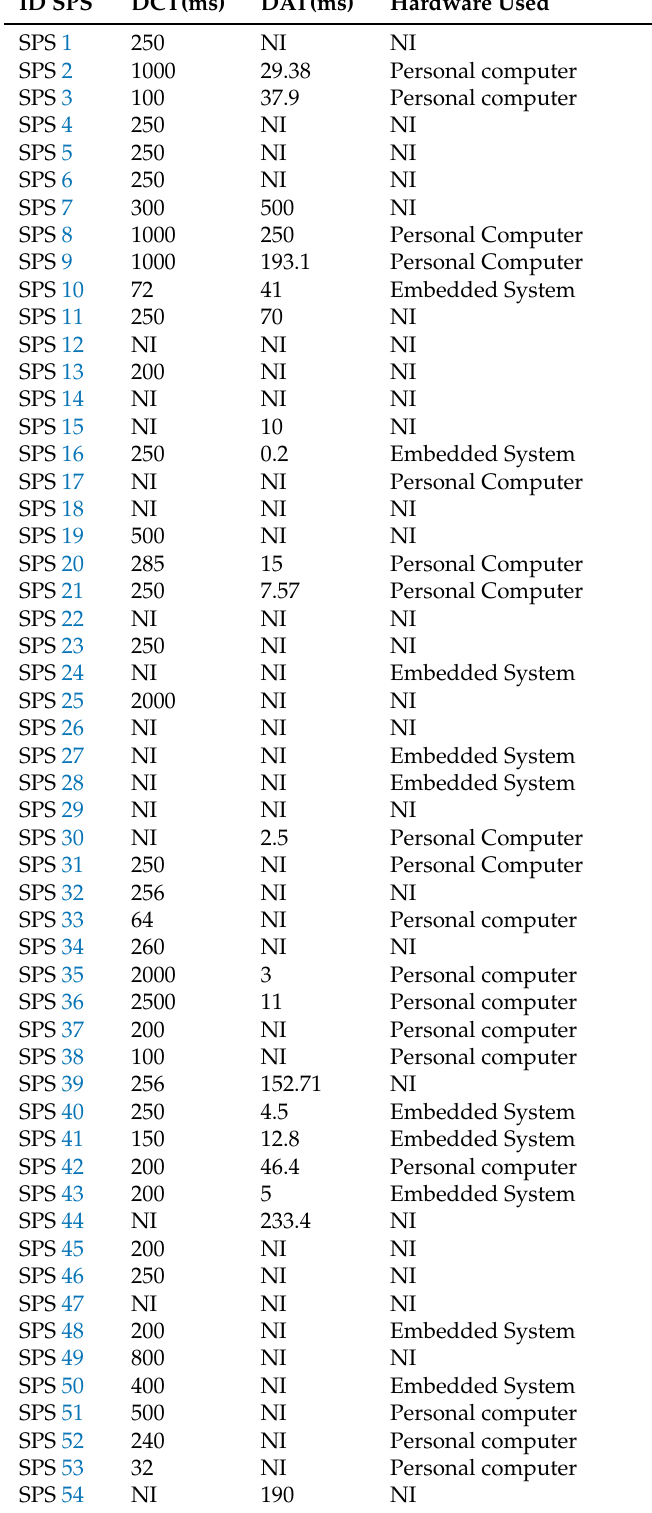
Table 10. Time of data collection and data analysis, and hardware used in the 65 HGR